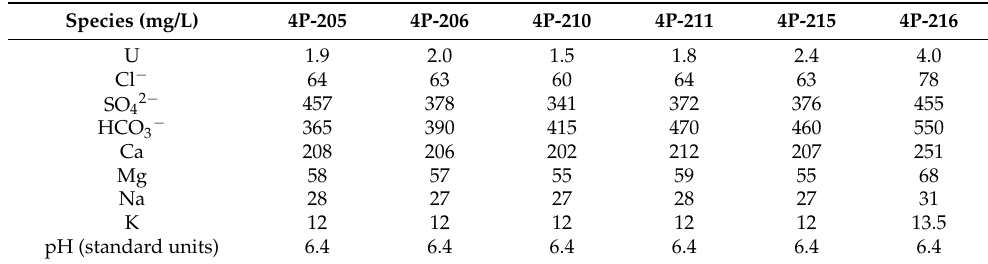
Table A3. Major ion chemistry in production wells used in the amendments test in early April 2018, prior to the start of the amendments test.